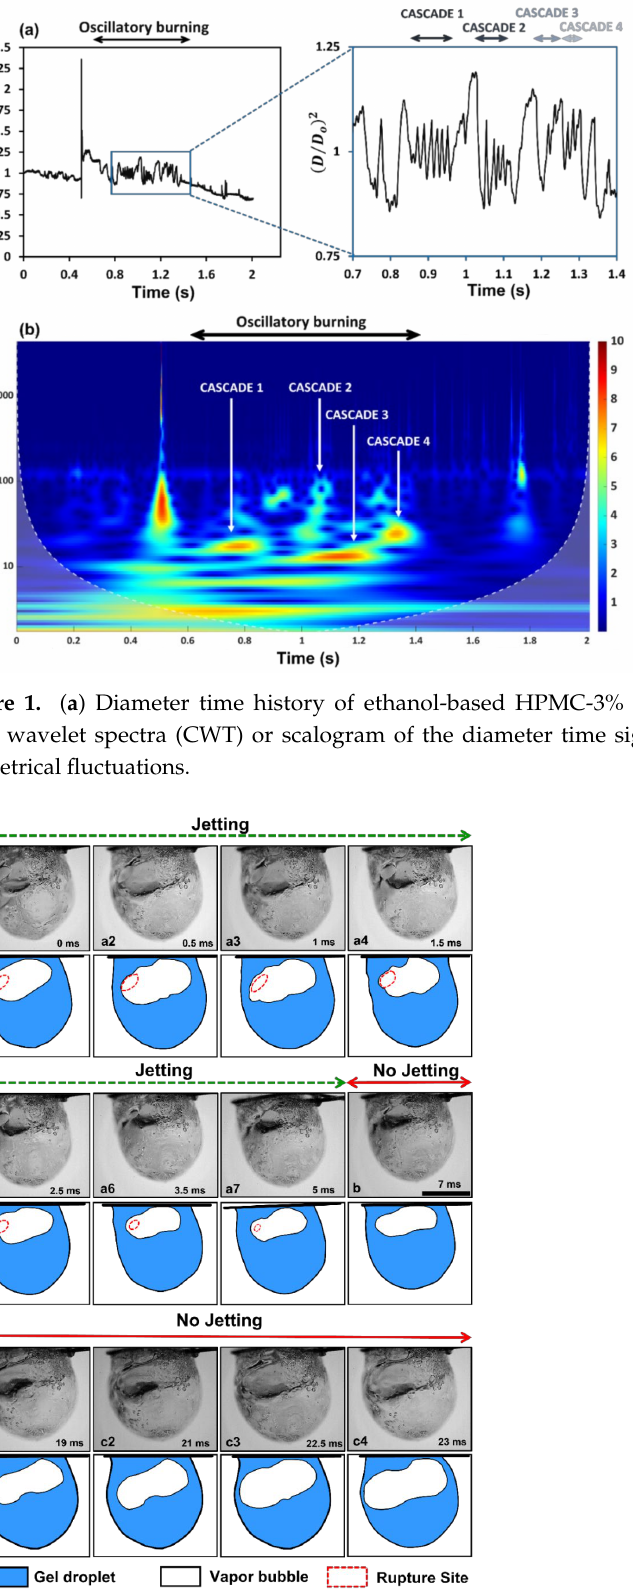
Figure 2. High-magnification images of a burning gel fuel droplet undergoing a single rupture– recovery cycle. The accompanying schematics are shown at the bottom of each image. ( a1 ) Rupture of the gellant shell and ( a2 – a7 ) jetting of unreacted fuel vapors from the rupture site. ( b ) Recovery of the rupture site. ( c1 – c4 ) Bubble growth and droplet expansion. The time stamps are shown on each image, and the scale bar equals 1 mm.